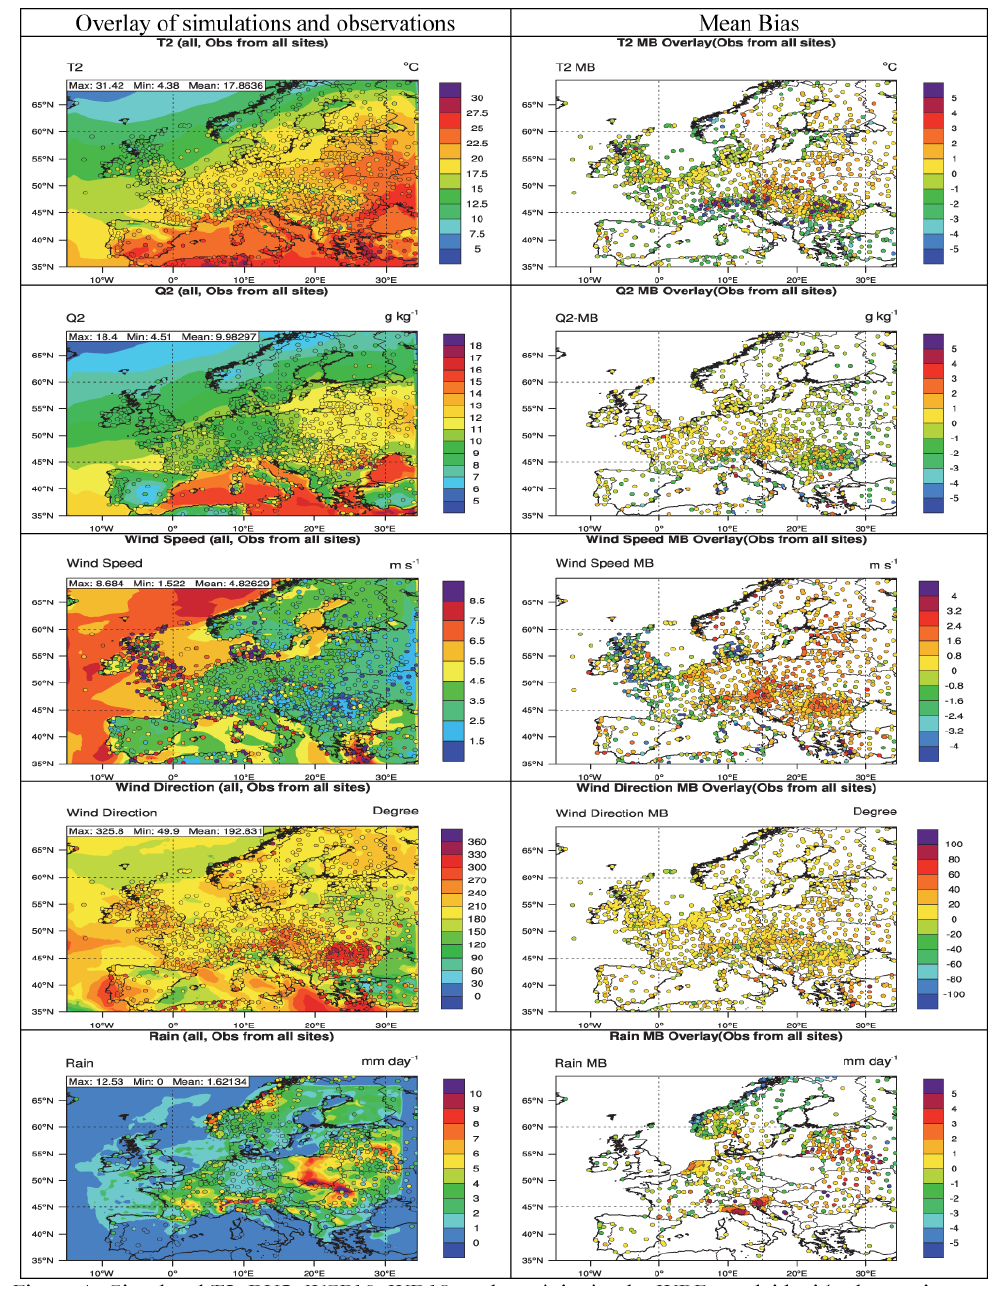
Fig. 4. Simulated T2, RH2, WSP10, WD10, and precipitation by WRF overlaid with observations in January 2001 (left column) and their associated mean biases (right column). Note that for WD10, 0 degree is equivalent to 360 degrees in the wind rose plot.